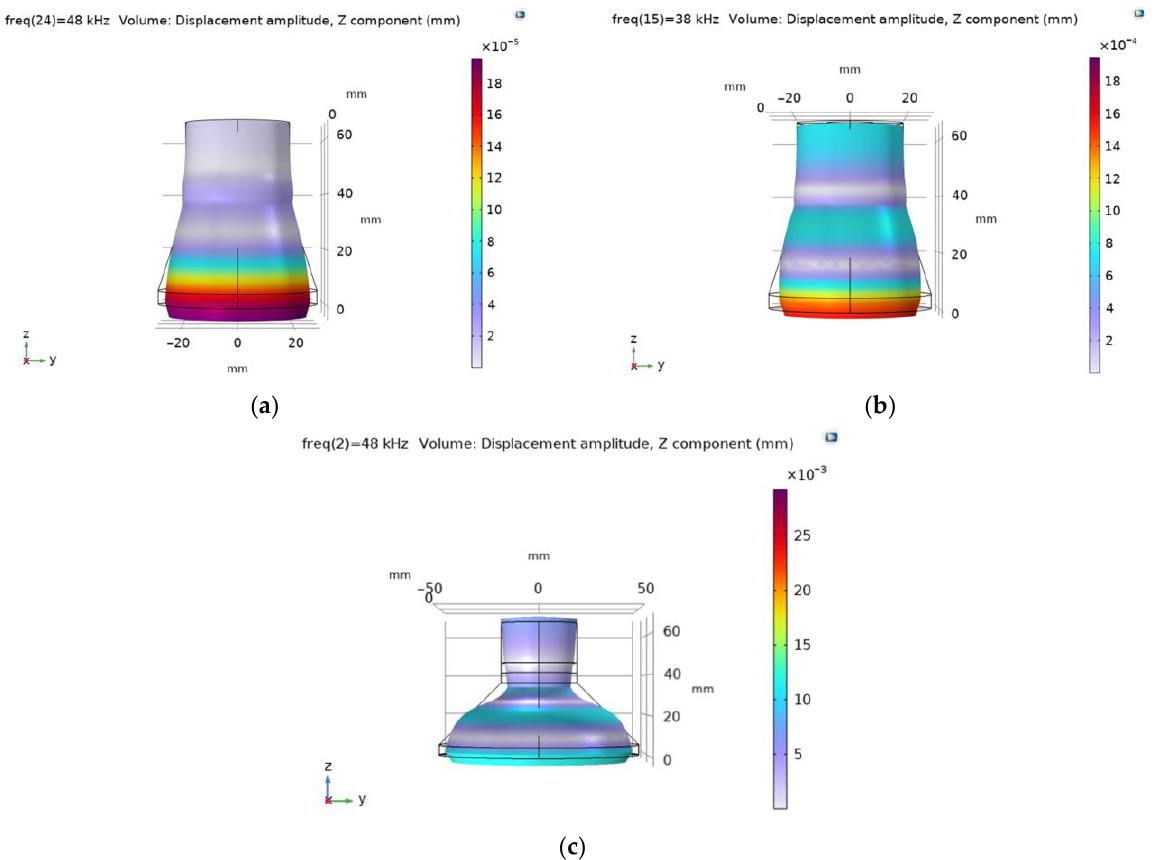
Figure 5. Modal shapes of the piezoelectric transducer at the first natural frequency: ( a ) with flat surface; ( b ) with 58 mm diameter ring-shaped surface; ( c ) with 100 mm diameter ring-shaped sur- face.